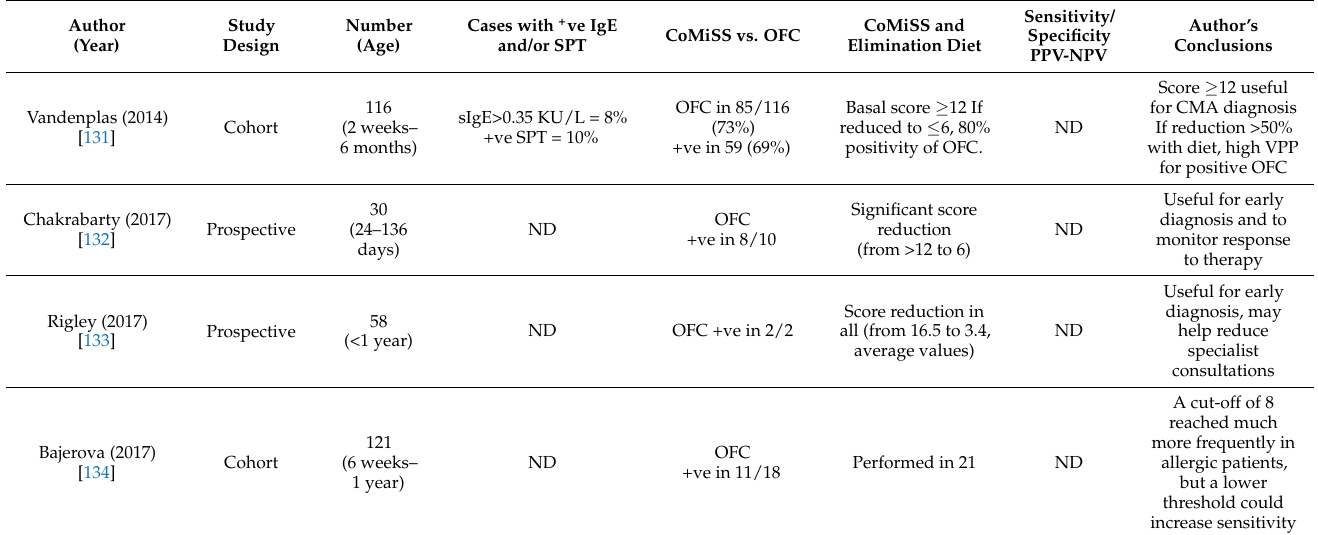
Table 6. Characteristics of studies dealing with